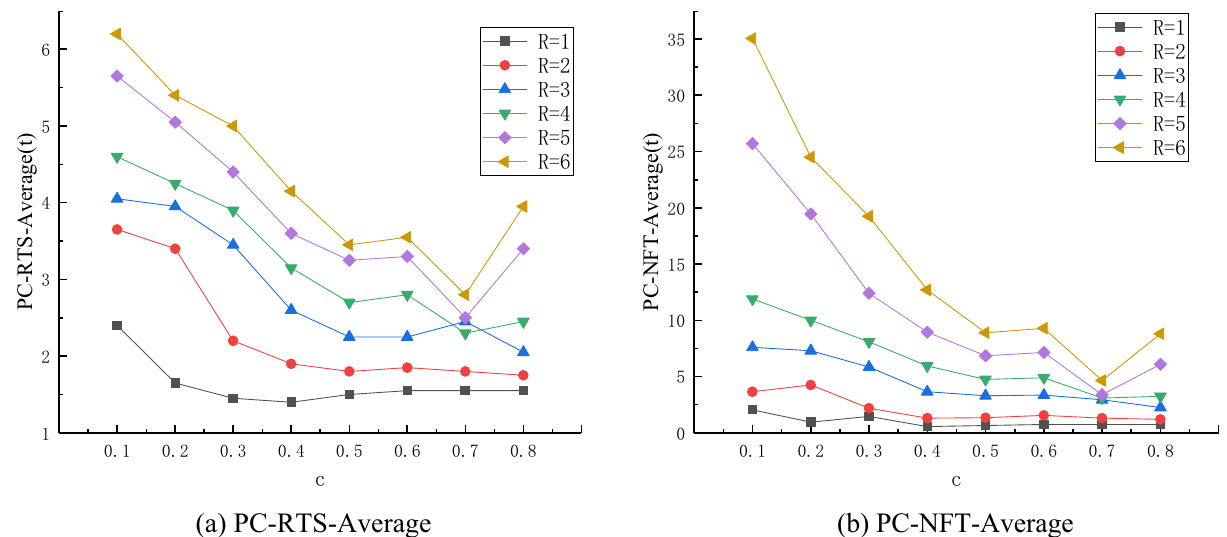
Figure 2. Relationship curve of different R and c values when pinning control node